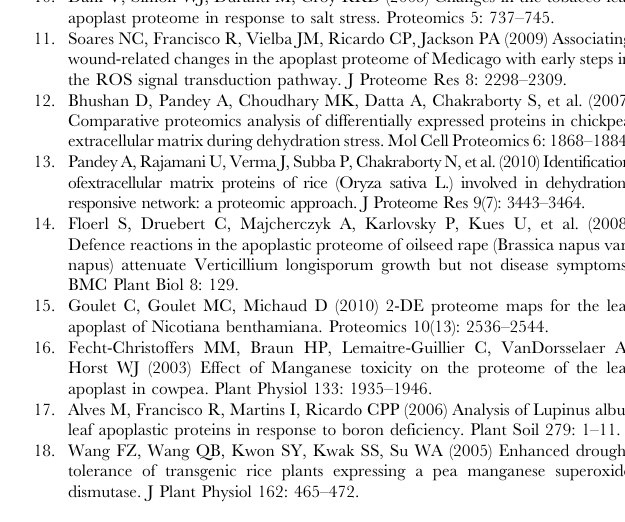
Figure S2 Hierarchical clustering of H 2 O 2 -responsive proteins associated with carbohydrate metabolism (A) and redox regulation (B). (DOCX) Figure S3 Schematic structure of the At-RLK3 protein and the RLP protein we identified (OsRMC). (DOCX) Table S1 Differentially expressed protein spots identified by PMF or MS/MS. Table S2 Peptide tags of proteins identified by MS/MS. Table S3 Redundancy of differentially displayed protein spots identified by PMF or MS/MS. Table S4 Localization prediction of proteins without signal sequences by the SecretomeP software. Table S5 List of common proteins in the rice apoplast proteome under different